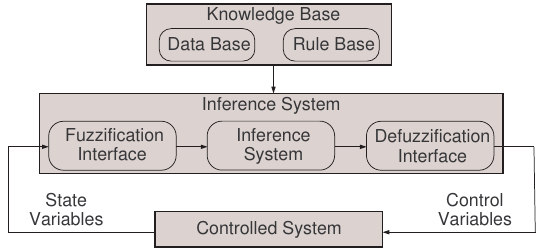
Fig. 1. Generic structure of a